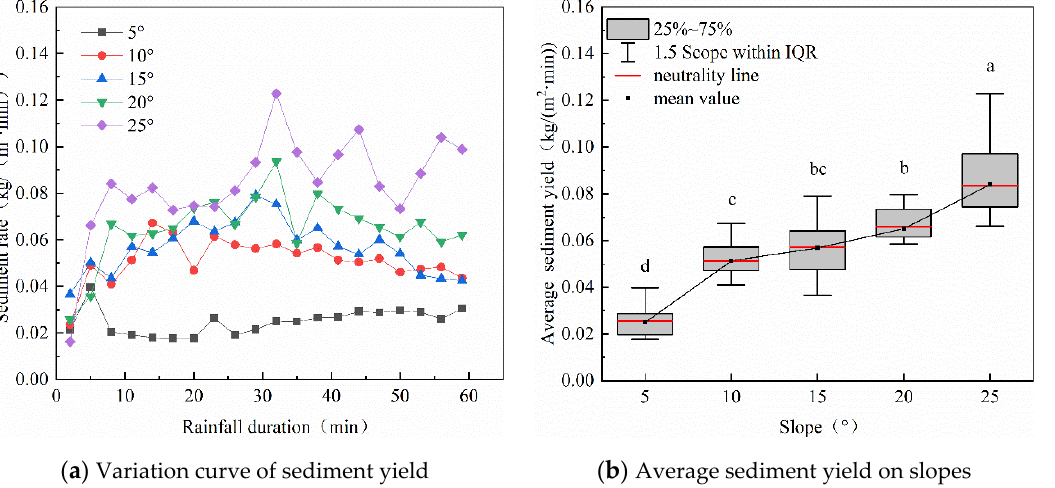
Figure 4. Effect of different slope gradients on sediment yield.